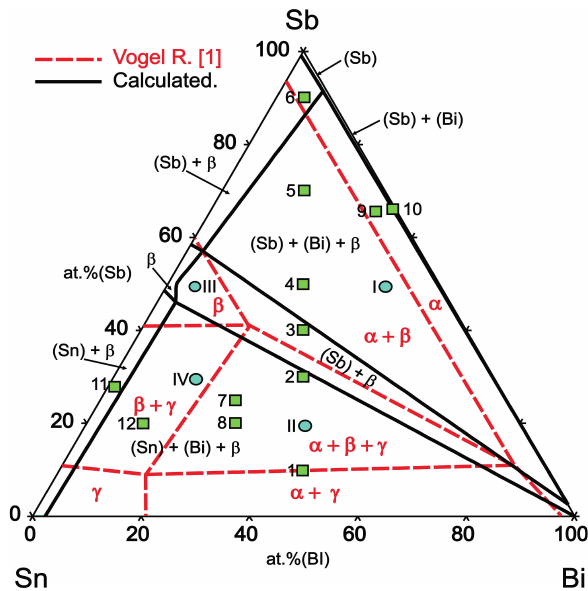
Figure 5. Comparative presentation of the calculated and isothermal section of the ternary Bi-Sb-Sn system at 298 K from literature [1].